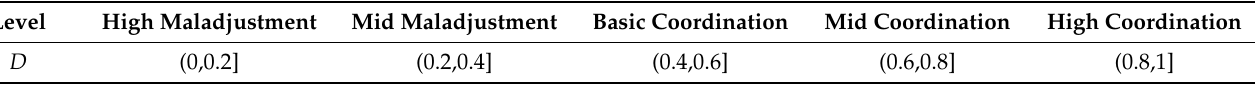
Table 5. Level of coordination degree between economic development and environmental